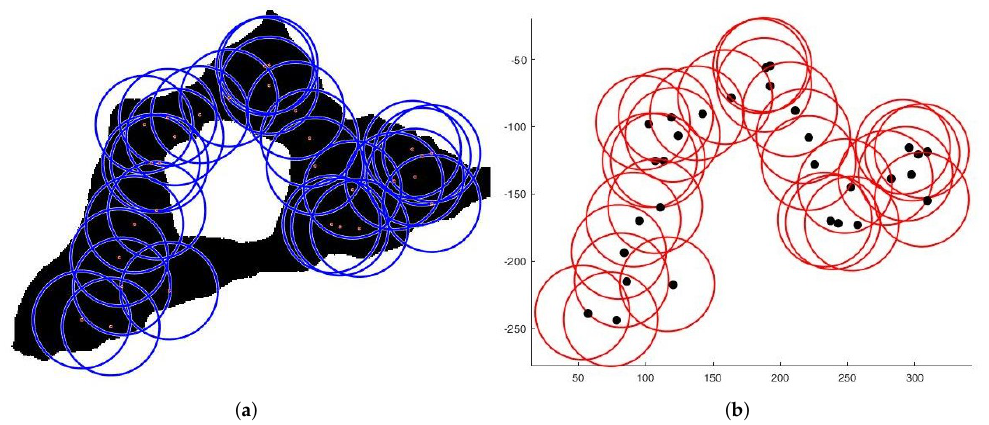
Figure 13. Deployment with one “no interest” area. ( a ) Final positioning. ( b ) Connectivity scheme.